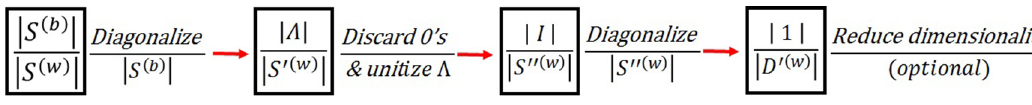
Figure 4. Block diagram of Direct Linear Discriminant Analysis